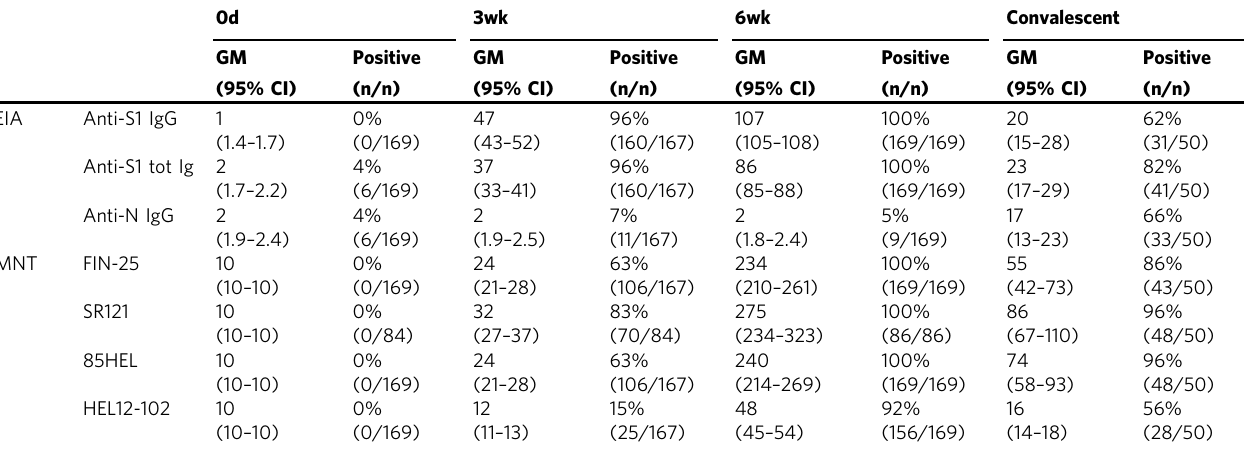
Table 1 Antibody responses in BNT162b2 vaccinated health care workers (HCW) without previous SARS-CoV-2 infection and non-hospitalized convalescent-phase COVID-19